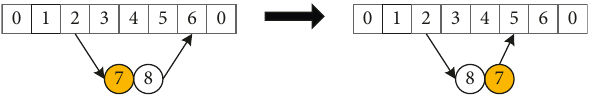
Figure 6: An example of the relocate operator for